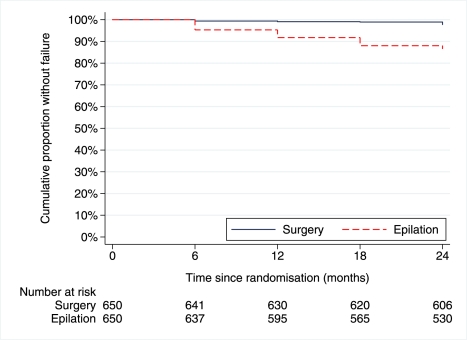
Kaplan Meier graph of time to failure.